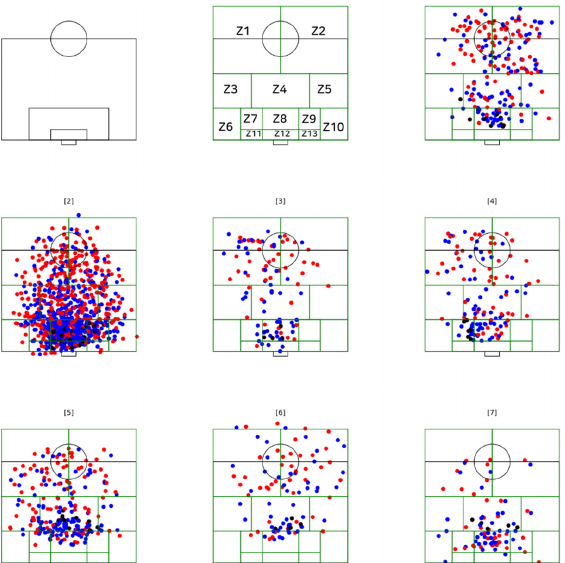
Figure 1. Plot space of use (pitch zone, 1 to 13) and distribution of players (attackers and defenders) was created in a numerical computing environment, by node ( 1 to 7 ), involving attackers and defenders in each goal scoring-related zone pitch division. Note on colours: red (attackers), blue (defenders) and black (goal scorers).